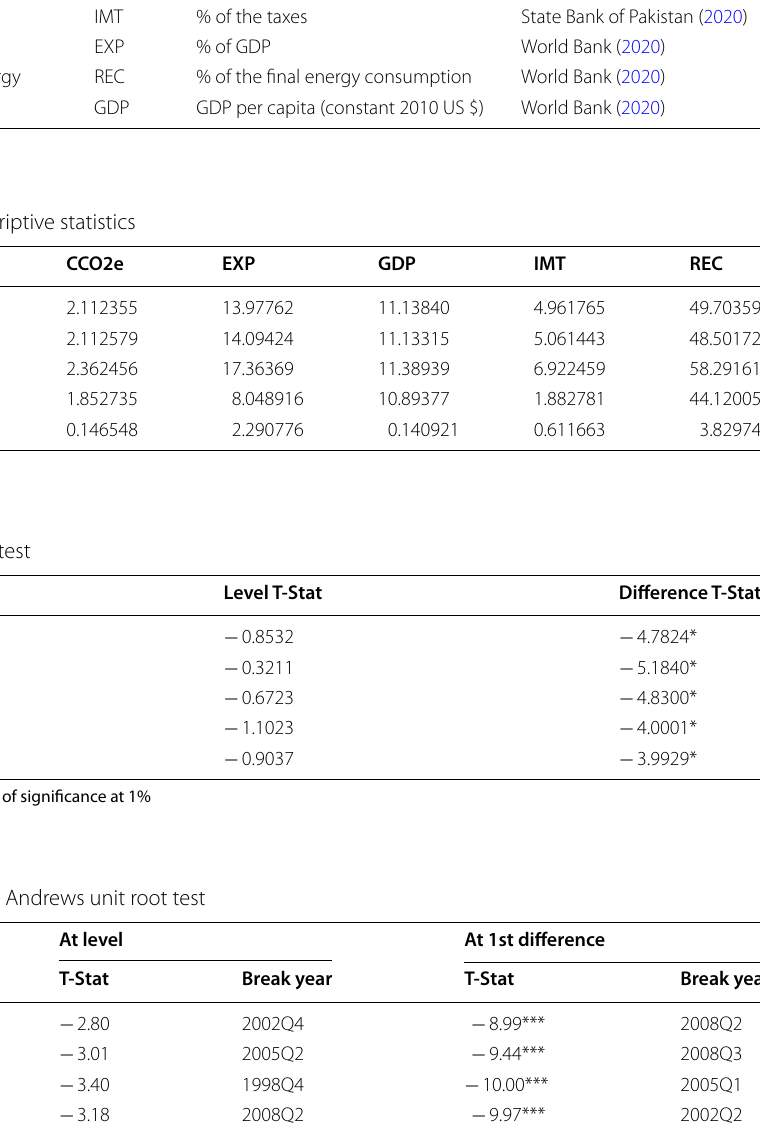
***Signifies the significance level at 1%